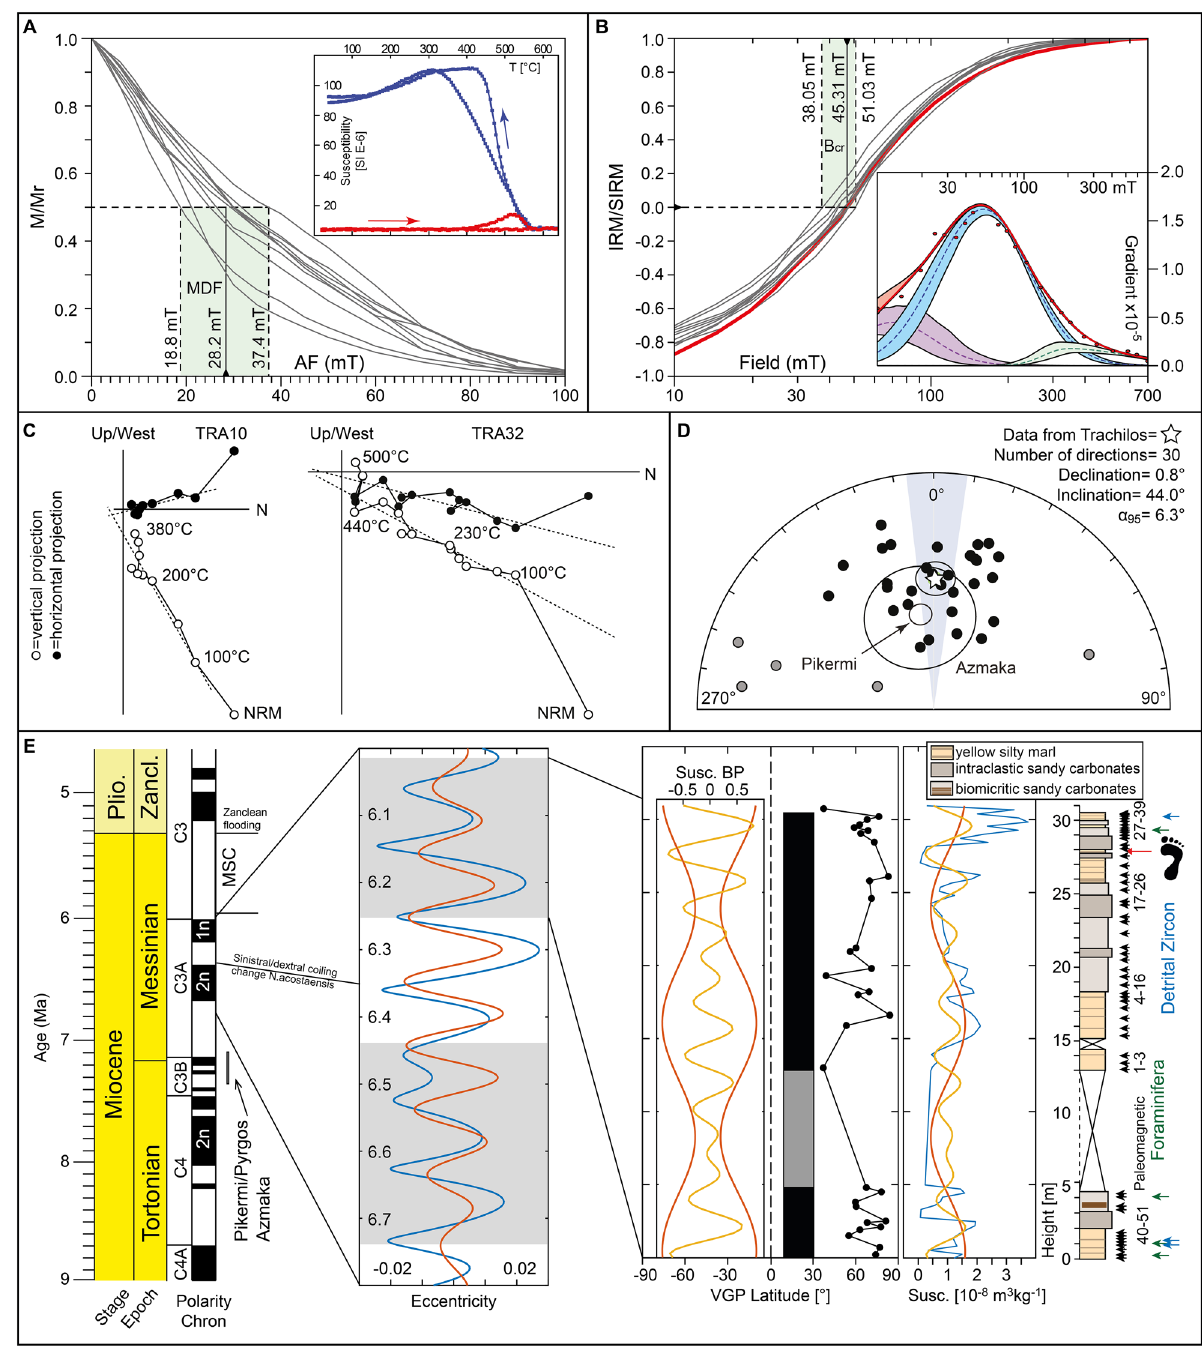
Figure 2. Paleomagnetic and cyclostratigraphic results of the Trachilos section. ( a ) AF demagnetization of ARM (normalized) with indication of the median destructive field (MDF), representative susceptibility vs. temperature curves are shown in the inset; ( b ) backfield IRM acquisition curves normalized for the saturation IRM (SIRM) with indication of the coercivity of remanence (B cr ); skewed generalized Gaussian-based IRM unmixing of a representative curve (red) (see supplementary information for further detail). ( c ) representative thermal demagnetization results. ( d ) Stereographic projection including results from Pikermi and Azmaka; a 95 = 95% confidence angle (Fisher, 1953), grey dots are discarded using a 45° virtual geomagnetic pole (VGP) cutoff. ( e ) From left to right: Timescale with stages and magnetic polarity for the 9.0–5.0 Ma interval of the late Miocene-Pliocene 25 . ~ 100 ka bandpass filter for the northern hemisphere insolation curve for the 6.0–6.8 Ma interval 26 . Plot of VGP latitude for the Trachilos samples with according polarity interpretation (black equals normal polarity and grey equals interval with no information), with the bandpass filtered susceptibility record. Susceptibility record (raw data in blue) together with two bandpass filters (red and yellow). Lithological column with positions of paleomagnetic (black), foraminifera (green) and detrital zircon (blue)